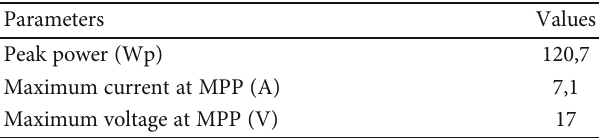
Table 3: Photovoltaic generator settings.